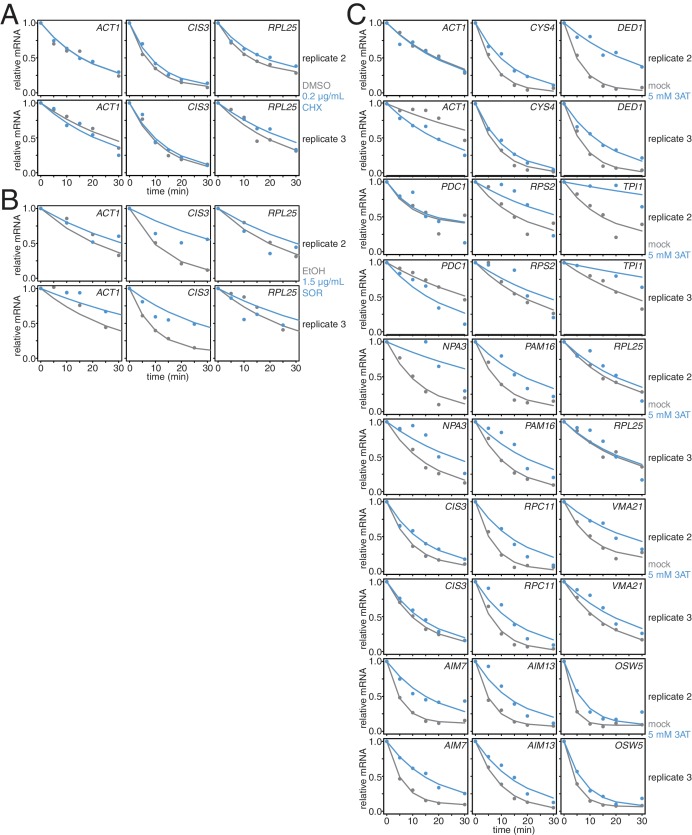
Biological replicates of experiments described in Figure 3I–J.(A) Two additional biological replicates of the experiment described in Figure 3B. (B) Two additional biological replicates of the experiment described in Figure 3C. (C) Two additional biological replicates of the experiment described in Figure 3D–G.